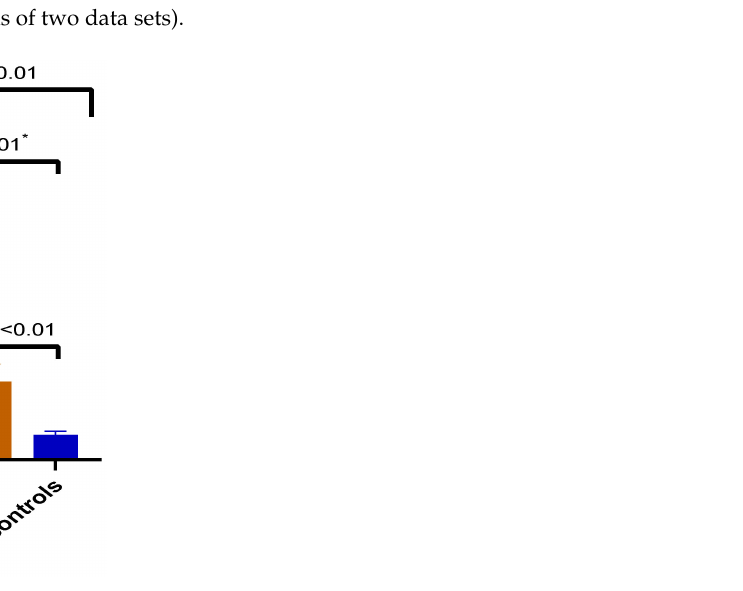
Figure 5. Comparison of max SR values between adenomyotic, leiomyoma lesions and controls. Legend: SR—strain ratio; *—Mann–Whitney test was used ( t test with Welch’s correction was used for other comparisons of two data